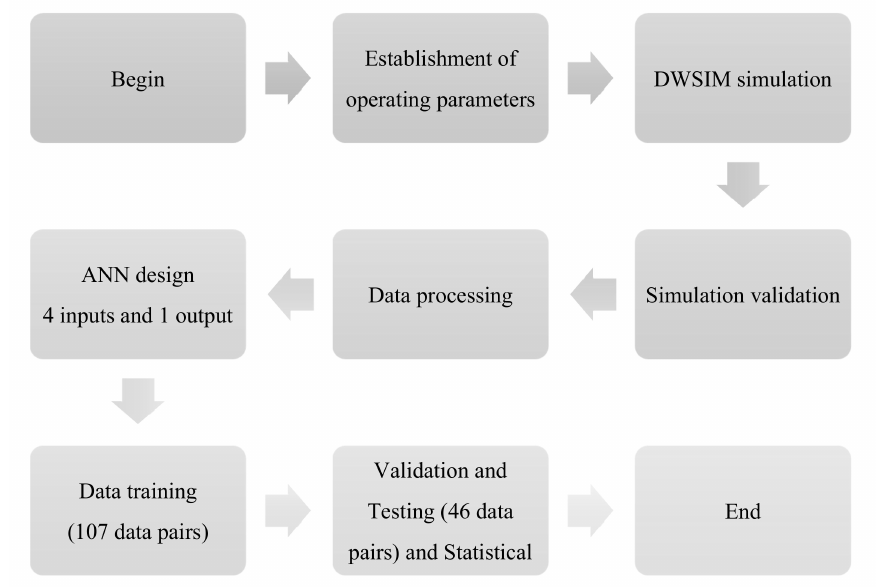
Figure 2. Methodology to devolopment the artificial neural networks